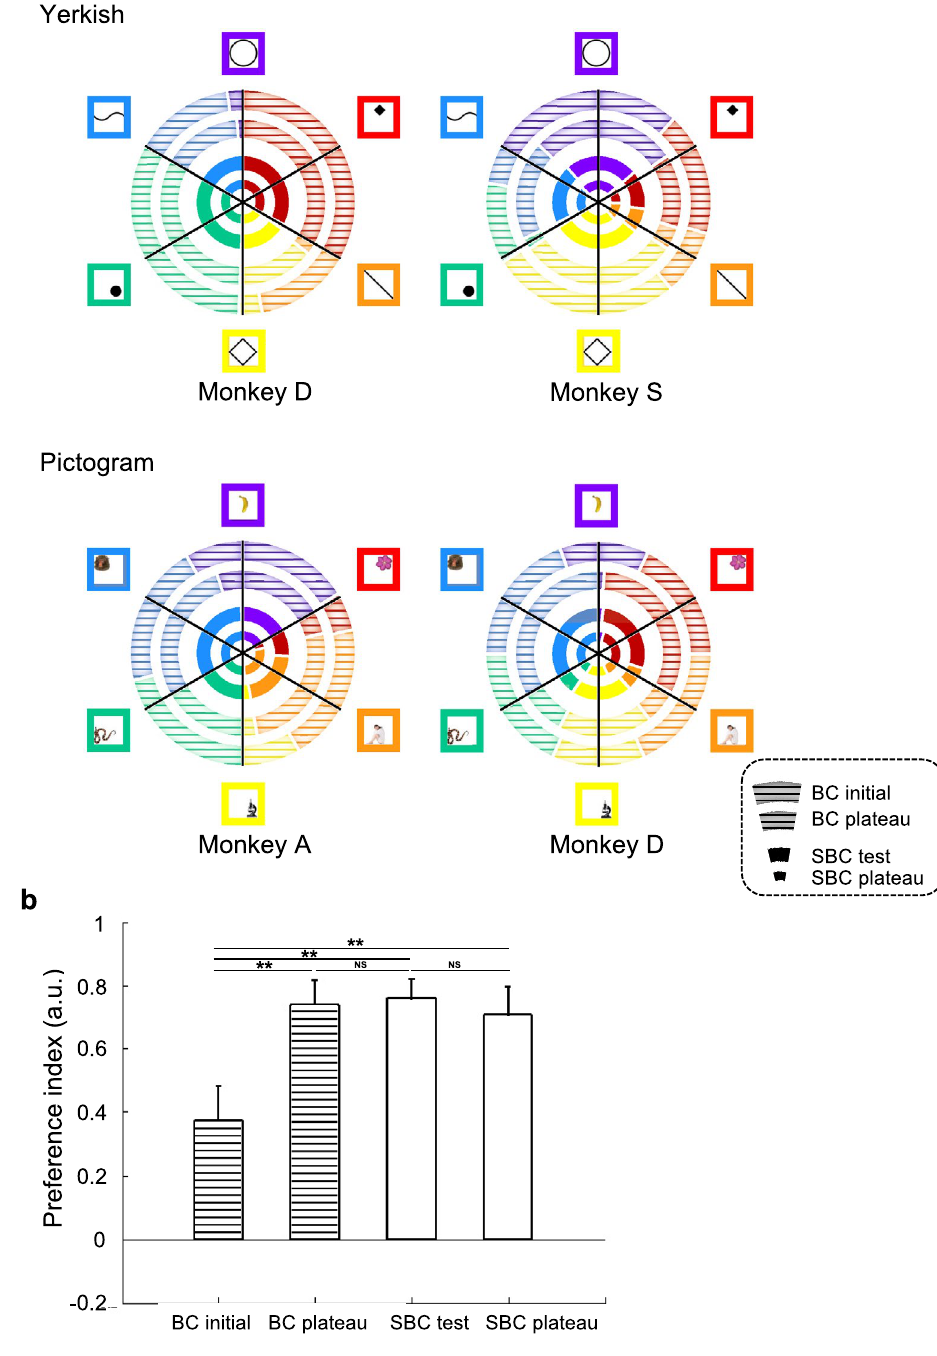
Figure 3. Development of choice order bias in individual monkeys. ( a ) Color charts indicating the preferred order whereby one of the paired elements constituting the Yerkish (upper) and pictogram (lower) bigram symbols is chosen first by individual monkeys. The striped outermost and the second outer circles indicate the choice order preference in the initial and plateau phases, respectively, of the BC task. The second inner and the innermost circles indicate the preference in the probe test and plateau phases, respectively, of the SBC task. Each of the six sectors is colored based on the probability that one of the paired elements is touched first by the monkeys (inset). ( b ) Preference index indicating the strength of the touch order bias (see “Methods”) in the initial and plateau phases of the BC task (striped), and the test and plateau phase of the SBC task (unstriped), respectively. The preference index for each task phase from all monkeys were pooled together and compared across task phases—BC initial vs. BC plateau, BC plateau vs. SBC test, SBC test vs. SBC plateau, BC initial vs. SBC test, and BC initial vs. SBC plateau, using a paired t- test with Bonferroni correction. Bars indicate standard errors of the mean (SEM) across 24 choice pairs for each monkey. ** p < 0.01; NS, not